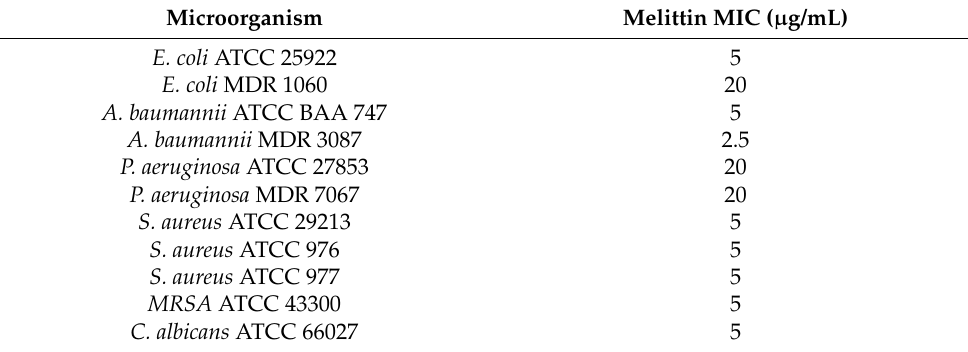
Table 1. Melittin MIC against different antimicrobial sensitive and resistant bacterial strains of gram-negative and -positive, in addition to C. albicans